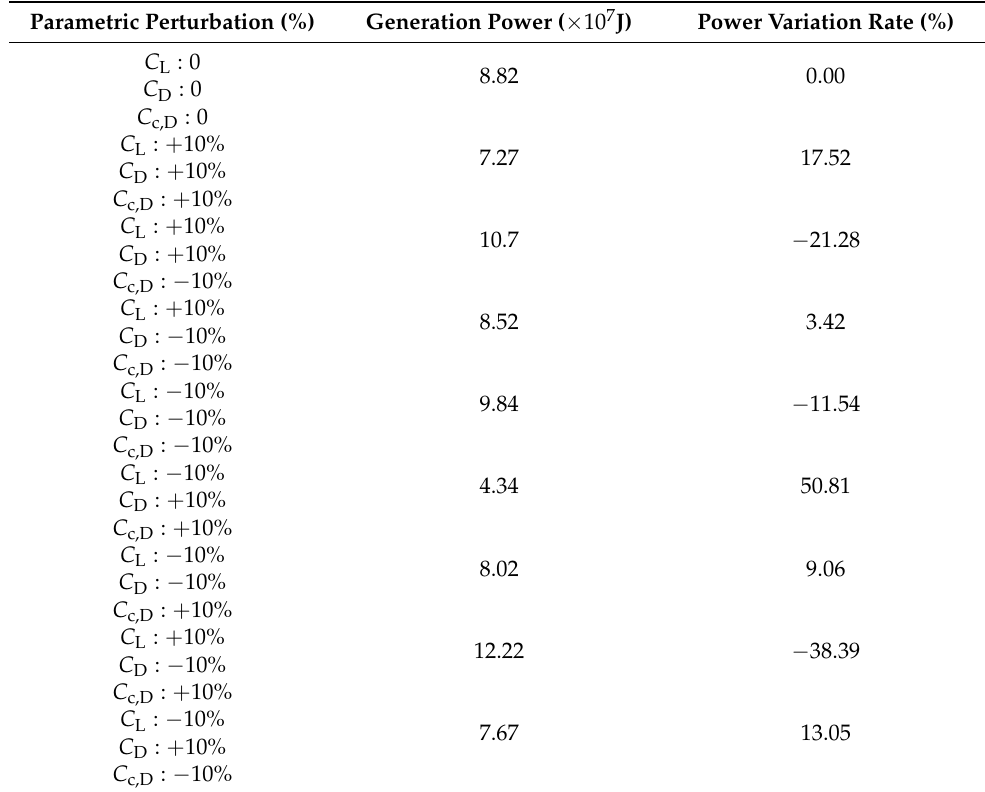
Table 6. Generation power in Monte Carlo simulation.